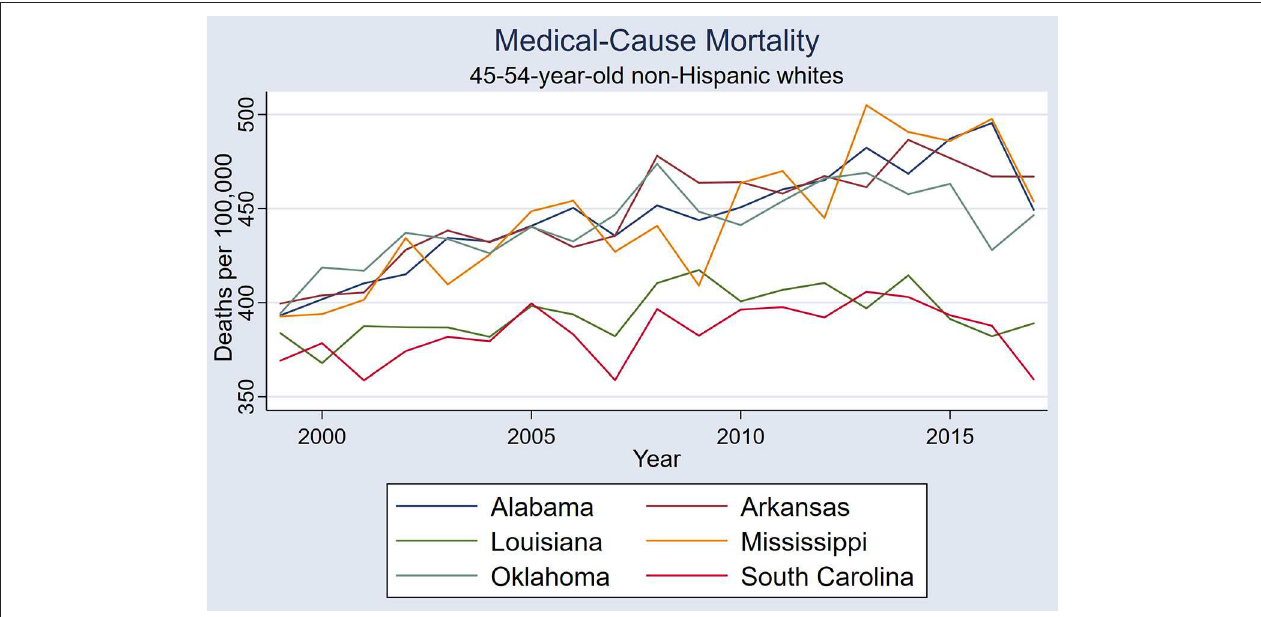
FIGURE 1 | Medical-cause mortality trends in the six states: Alabama, Arkansas, Louisiana, Mississippi, Oklahoma, and South Carolina.